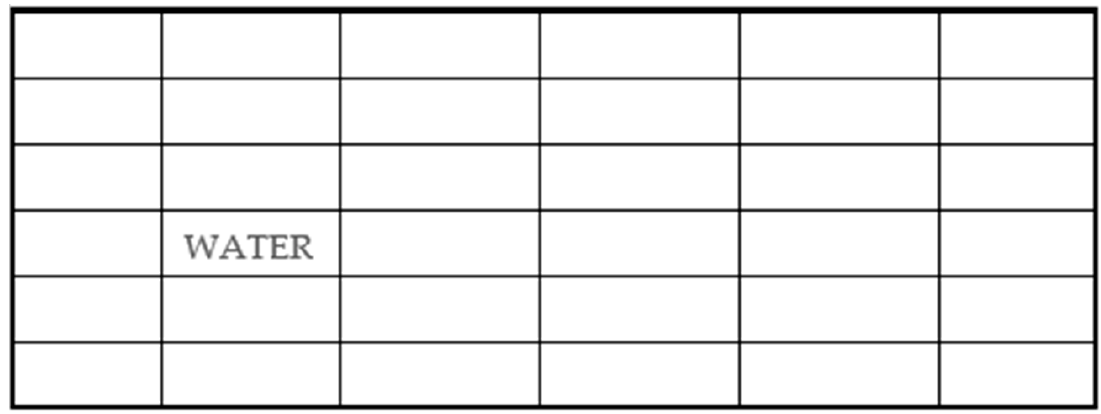
Figure 8. This is the Working Navigation Map WNM’ <y> that occurred after the best match temp-